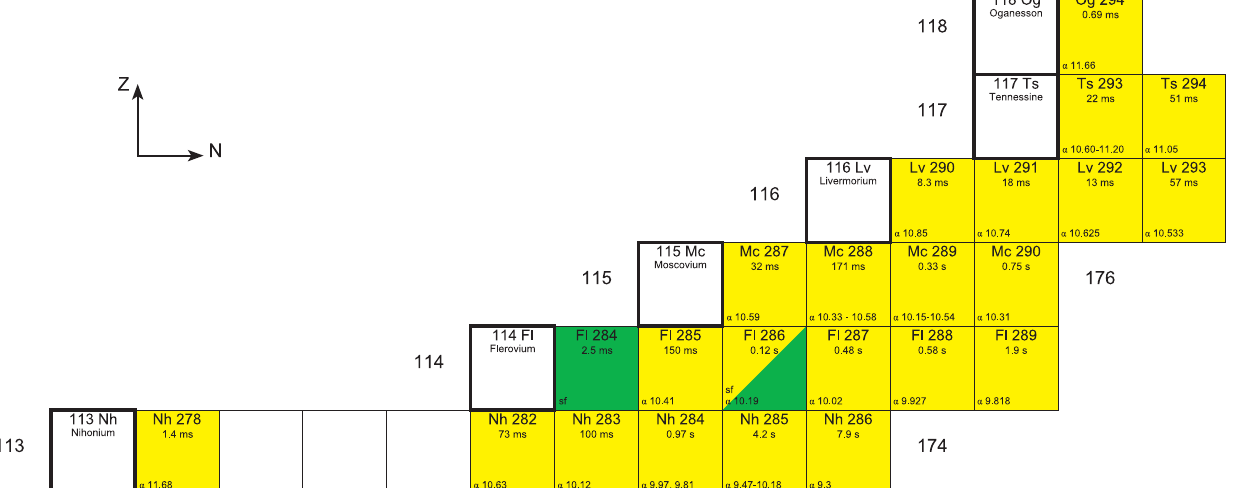
Fig. 2. New symbols for chemical elements in the Karlsruhe Nuclide Chart. Symbol Nh in line 113, Mc in 115, Ts in 117 and Og in 118. Table 1. The 47 newly discovered nuclides and isomers in the 10th edition of the Karlsruhe Nuclide Chart. F